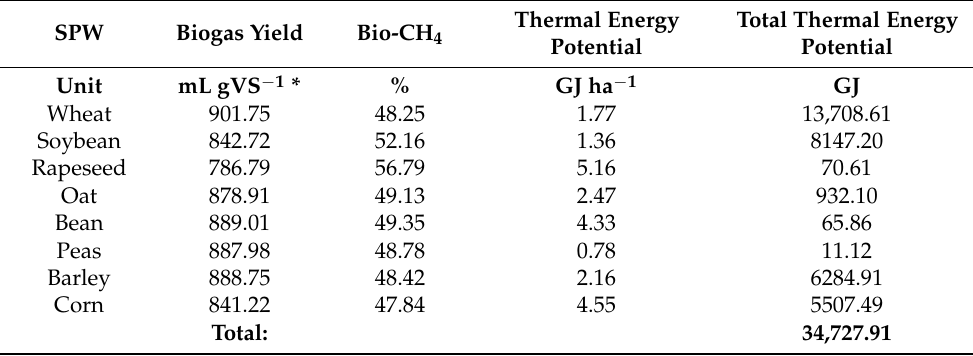
Table 4. Theoretical thermal energy potential of SPWs from Croatian seed production program; biogas power plants (2022); available quantities of each feedstock was calculated and presented in Table